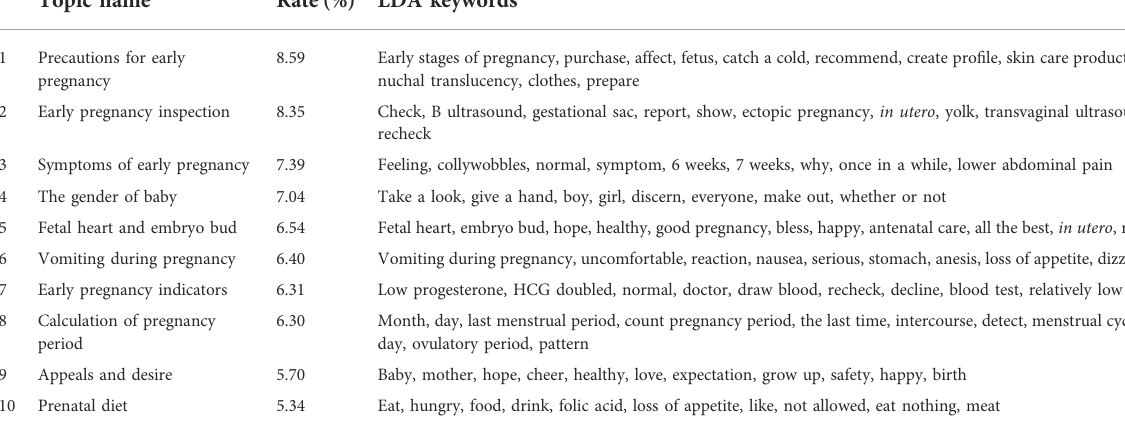
TABLE 5 Topics in the second month of